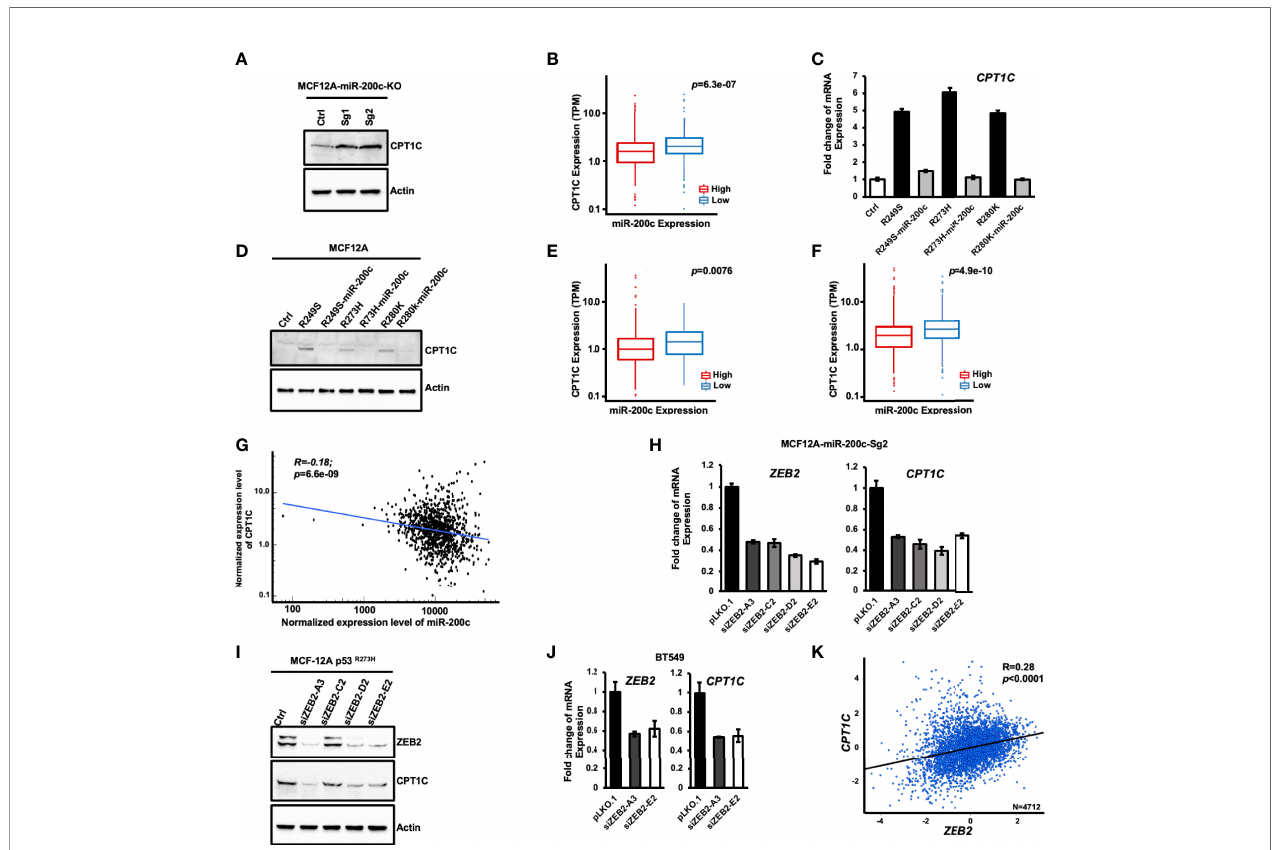
FIGURE 6 | Mutant p53 activates CPT1C expression through the miR-200c-ZEB2 axis. (A) miR-200c-de fi ciency leads to enhanced expression of CPT1C in mammary epithelial cells. The expression of CPT1C and Actin in control (Ctrl) and miR-200c-KO MCF12A cells (MCF12A-Sg1 and MCF12A-Sg2) were examined by immunoblotting. (B) The box and whisker plot of CPT1C expression in p53 wide-type breast cancer patients (n = 657) from TCGA with high (n = 328) or low miR- 200c expression (n = 329). The statistical signi fi cance of differential CPT1C expression in miR-200c high expression and low expression groups was determined by Wilcoxon rank-sum test. p: corresponding p-value. (C, D) Restoring the expression of miR-200c compromises the enhanced CPT1C expression caused by mutant p53. The expression of CPT1C in control (MCF12A-Ctrl), p53 mutant cells (MCF12A-p53 R249S , MCF12A-p53 R273H and MCF12A-p53 R280K ) and miR-200c- overexpressing p53 mutant cells (MCF12A-p53 R249S -miR-200c, MCF12A-p53 R273H -miR-200c and MCF12A-p53 R280K -miR-200c) were examined by Q-PCR (C) or immunoblotting (D) . (E) The box and whisker plot of CPT1C expression in breast cancer patients (n = 290) harboring p53 missense mutations with high (n = 145) or low miR-200c expression (n = 145). Statistic method: Wilcoxon rank-sum test. p: corresponding p-value. (F) The box and whisker plot of CPT1C expression in total breast cancer patients (n = 1074) from TCGA with high (n = 537) or low miR-200c expression (n = 537). Statistic method: Wilcoxon rank-sum test. p: corresponding p-value. (G) The Spearman correlation plot for CPT1C versus miR-200c in total breast cancer patients from the TCGA database. R: correlation coef fi cient value; P: corresponding p-value. (H – J) Knockdown of ZEB2 interferes with the enhanced expression of CPT1C in miR-200c-KO (H) . MCF12A-miR-200c-Sg2), p53 mutant- overexpressing (I) , MCF12A-p53 R273H ), and BT549 (J) cells. (K) The Pearson ’ s pairwise correlation plot for CPT1C versus ZEB2 in total breast cancer patients from TCGA. R: correlation coef fi cient value; P: corresponding p-value. The result is derived from bc-GeneExMiner v4.5